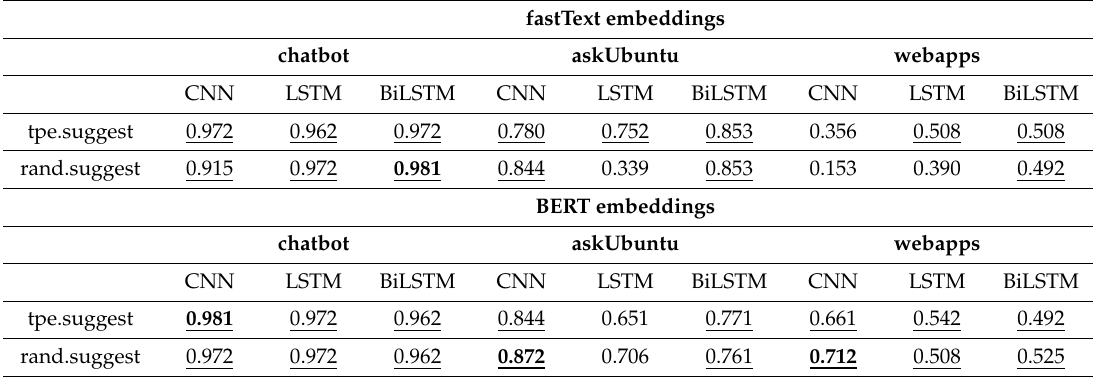
Table 8. Evaluated accuracies on the Lithuanian testing datasets with optimized models. For the other notation, see Table 5. fastText embeddings chatbot askUbuntu webapps CNN LSTM BiLSTM CNN LSTM BiLSTM CNN LSTM BiLSTM